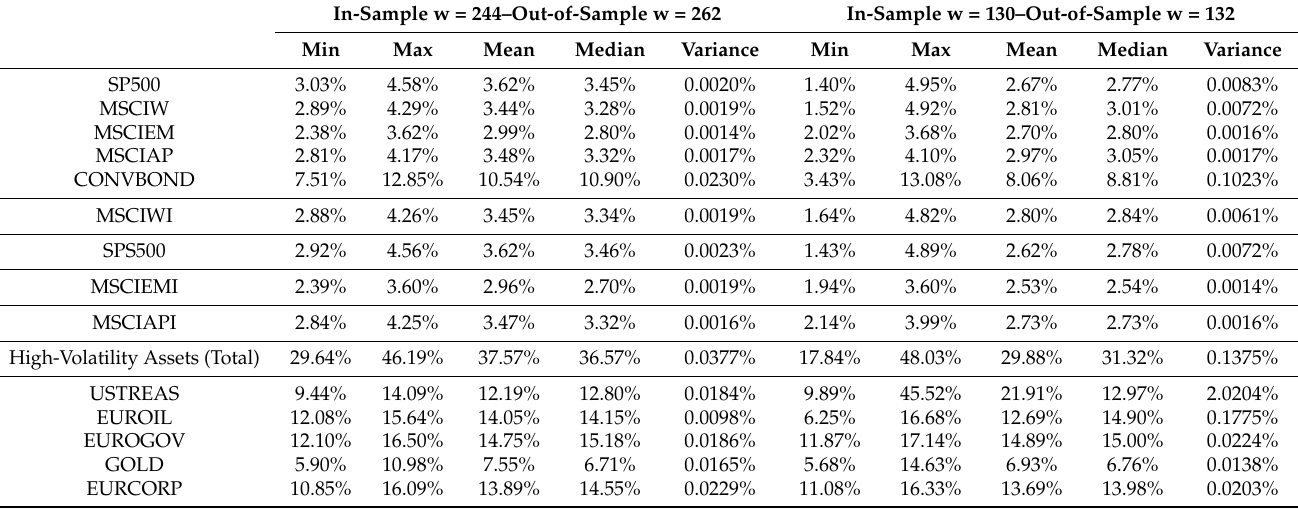
Table 9. Asset marginal weight contribution to the Combined